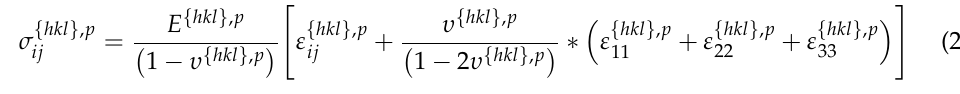
Figure 6. Stress–strain curves from continuous testing using a standardised tensile test (the curves with the designation ‘laboratory’ were added as benchmark data) from interrupted testing performed during the in situ diffraction experiment at SALSA with a relaxation-driven stress–strain decrease in each step.